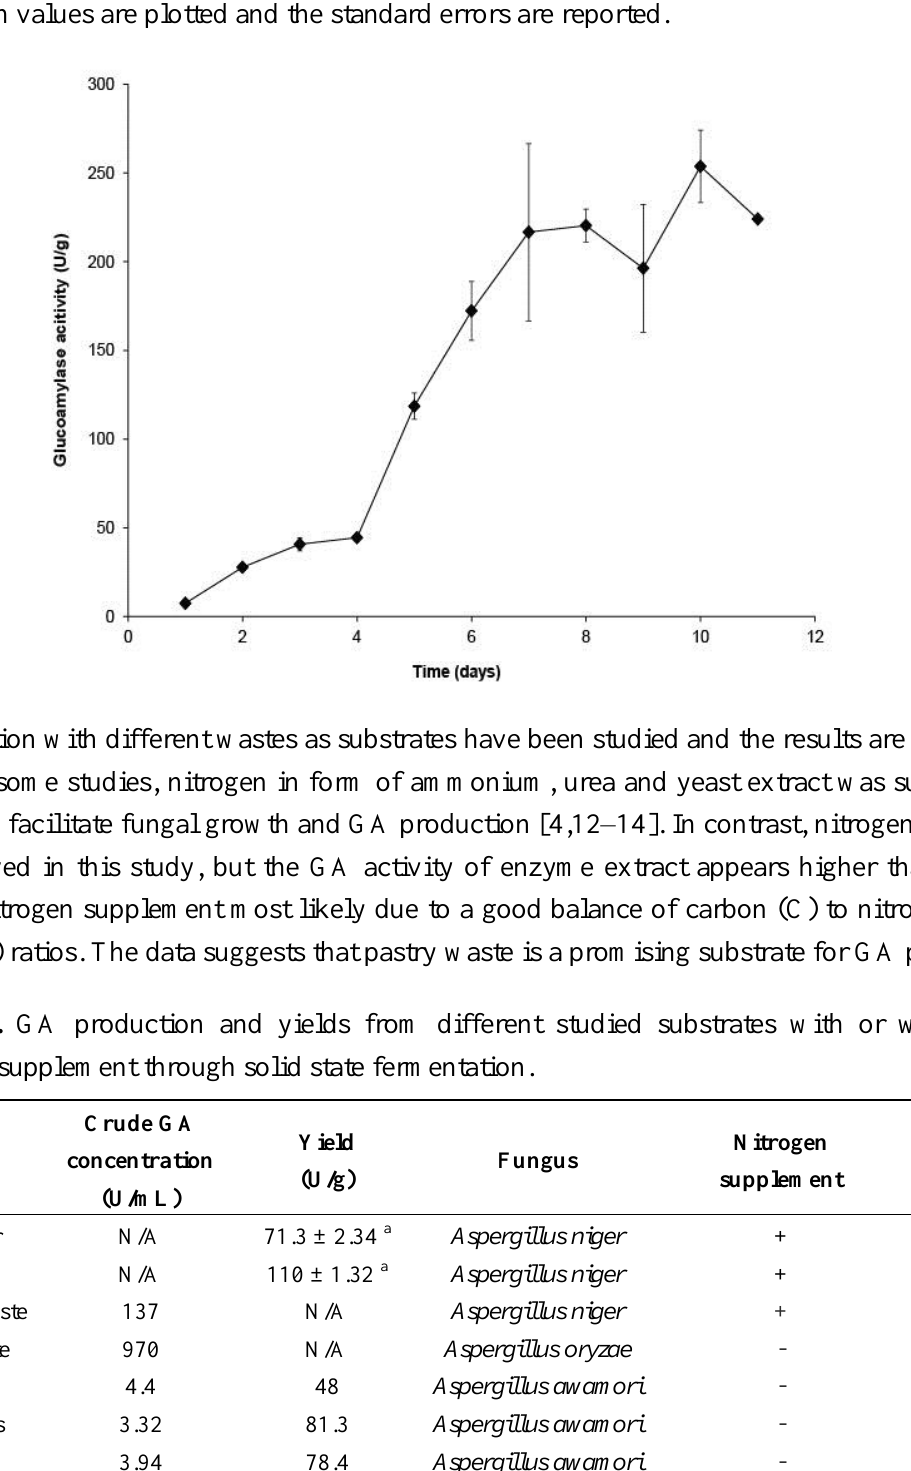
Figure 1. Glucoamylase (GA) production from pastry waste with Aspergillus awamori during solid state fermentation (SSF) for 11 days at 30 °C. Experiments were duplicated. The mean values are plotted and the standard errors are reported.